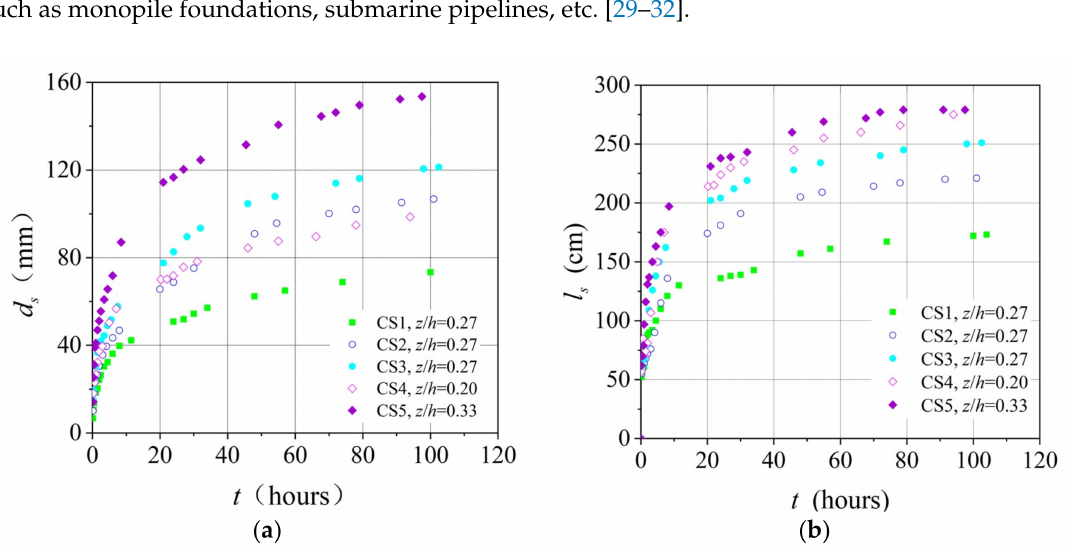
Figure 3. Temporal evolution of scour depth ( a ) and scour length ( b